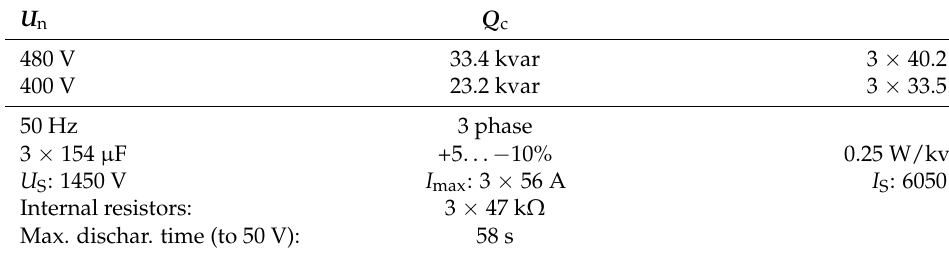
Table A2. Capacitor rated data.